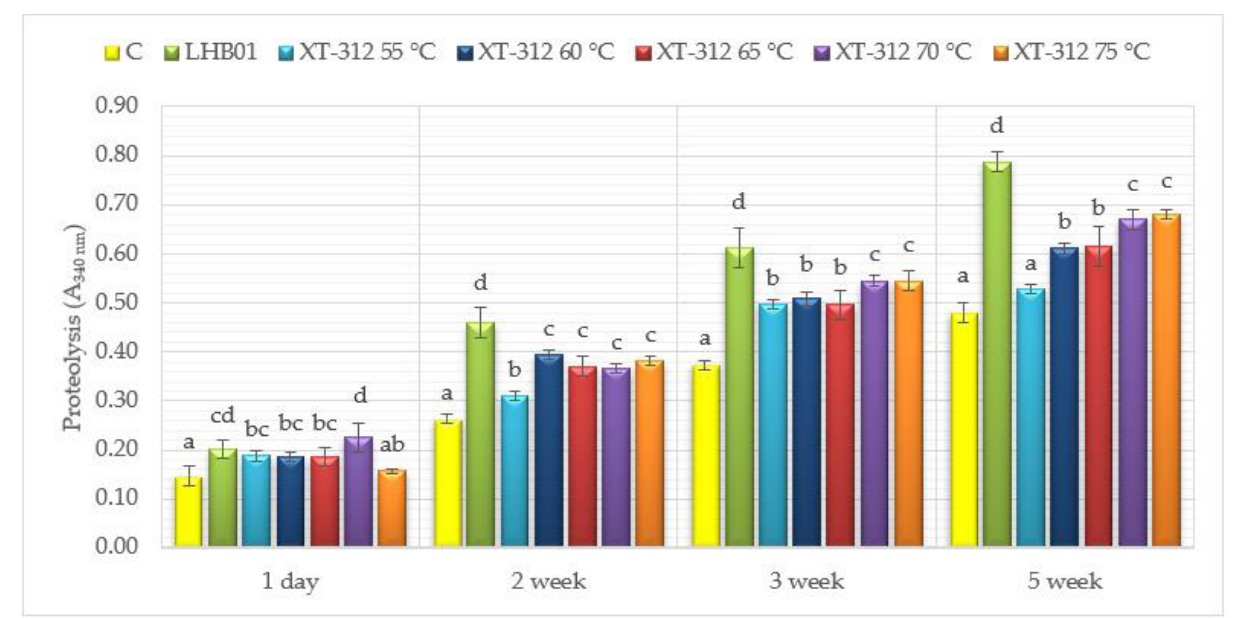
Figure 1. Proteolysis during ripening of Dutch-type cheese models (mean values and standard deviations, a–d homogenous groups, p < 0.05, n = 6).